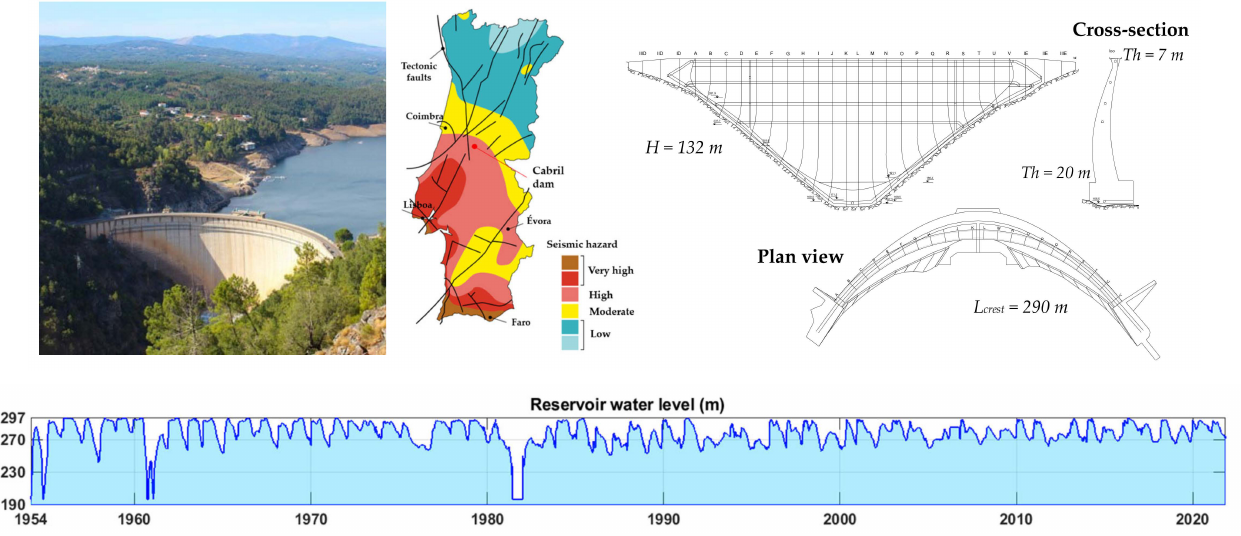
Figure 7. Case study I: Cabril Dam. Location and seismic hazard zones. Upstream, cross-section and plan views. Variation of the reservoir level over